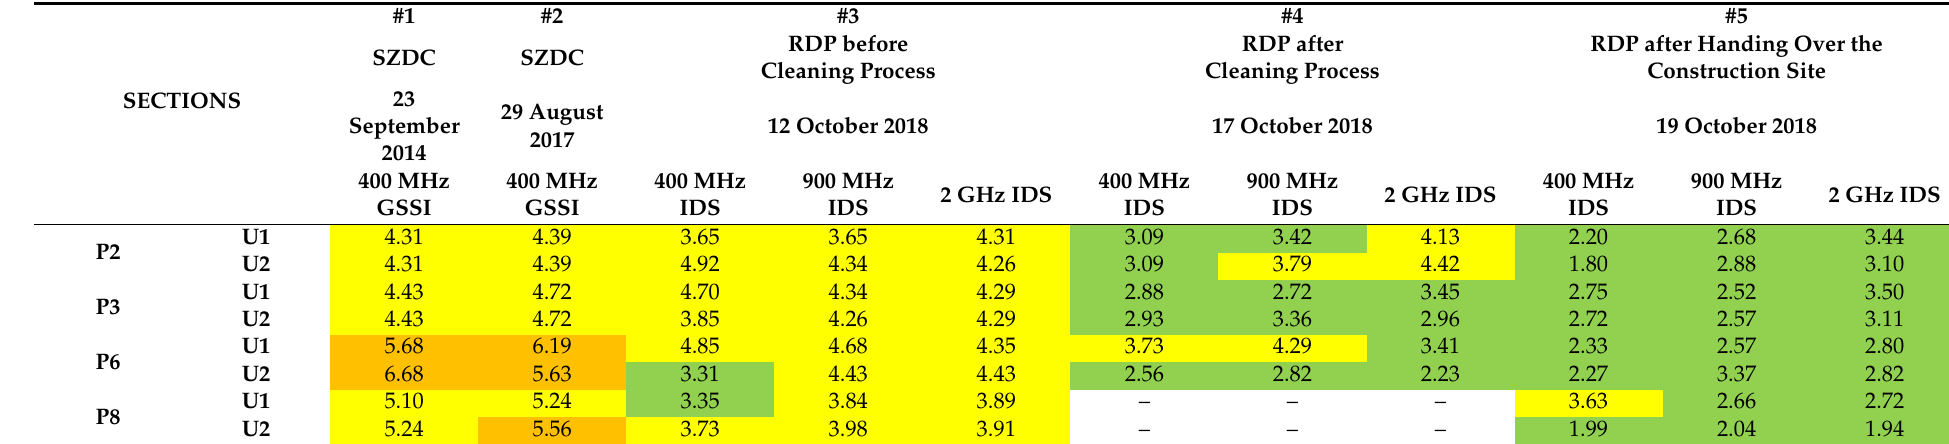
Table 8. RDP values of granite ballast layers for each section and survey phase (colors correspond to Table 7).